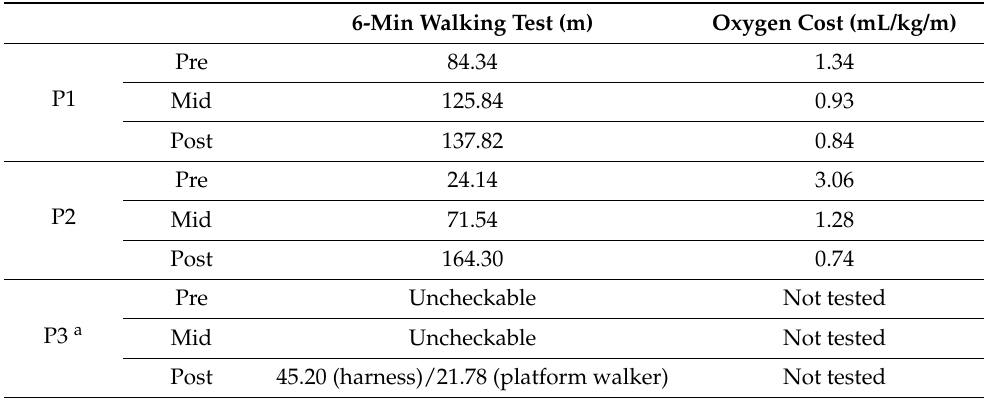
Table 4. Gait endurance and oxygen consumption in children with cerebral palsy before and after robot-assisted gait